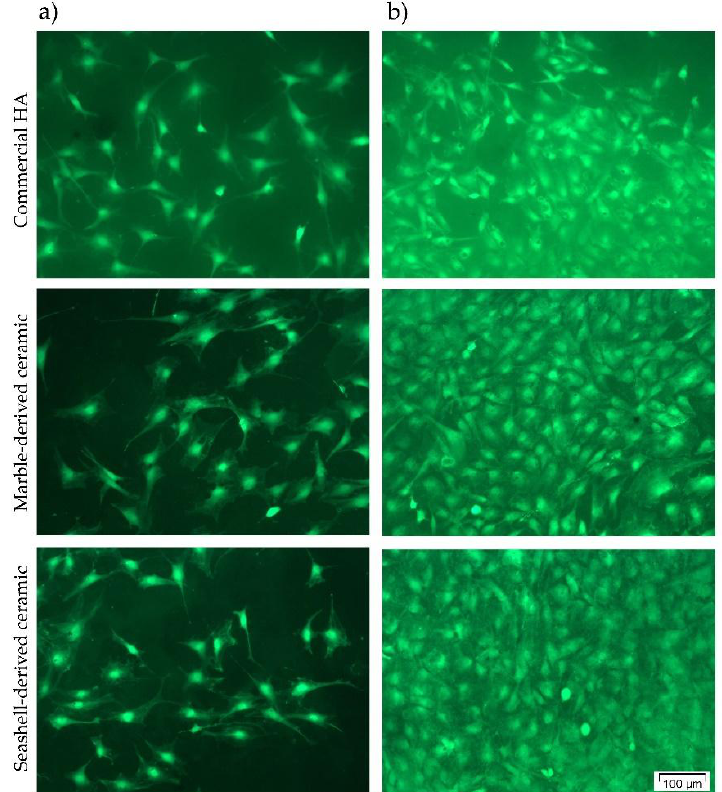
Figure 6. Fluorescence microscopy images of the MC3T3-E1 cells grown in contact with commercial HA and marble- and seashell-derived ceramics for 1 day ( a ) and 4 days ( b ). The cells were stained with a LIVE/DEAD Cell Viability/Cytotoxicity Assay Kit (live cells fluorescence green; no red fluorescent dead cells are present). Scale bar: 100